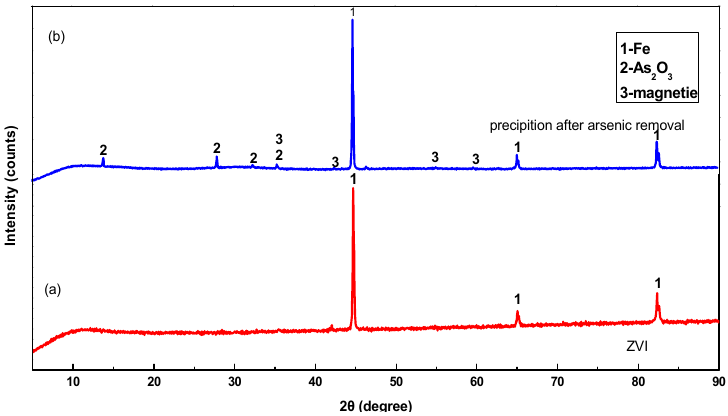
Figure 5. ( a ) XRD analysis of ZVI at a reaction time of 0 min. ( b ) XRD analysis of ZVI at a reaction time of 30 min.